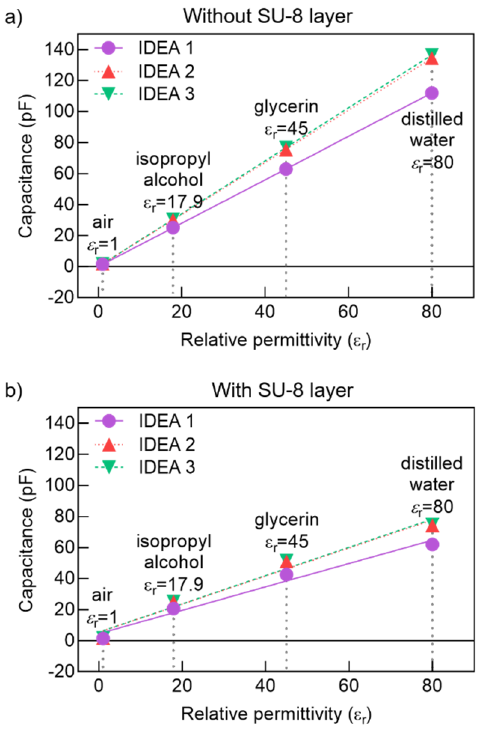
Figure 11. Capacitance simulation results: ( a ) without SU-8 layer and ( b ) with SU-8 layer.